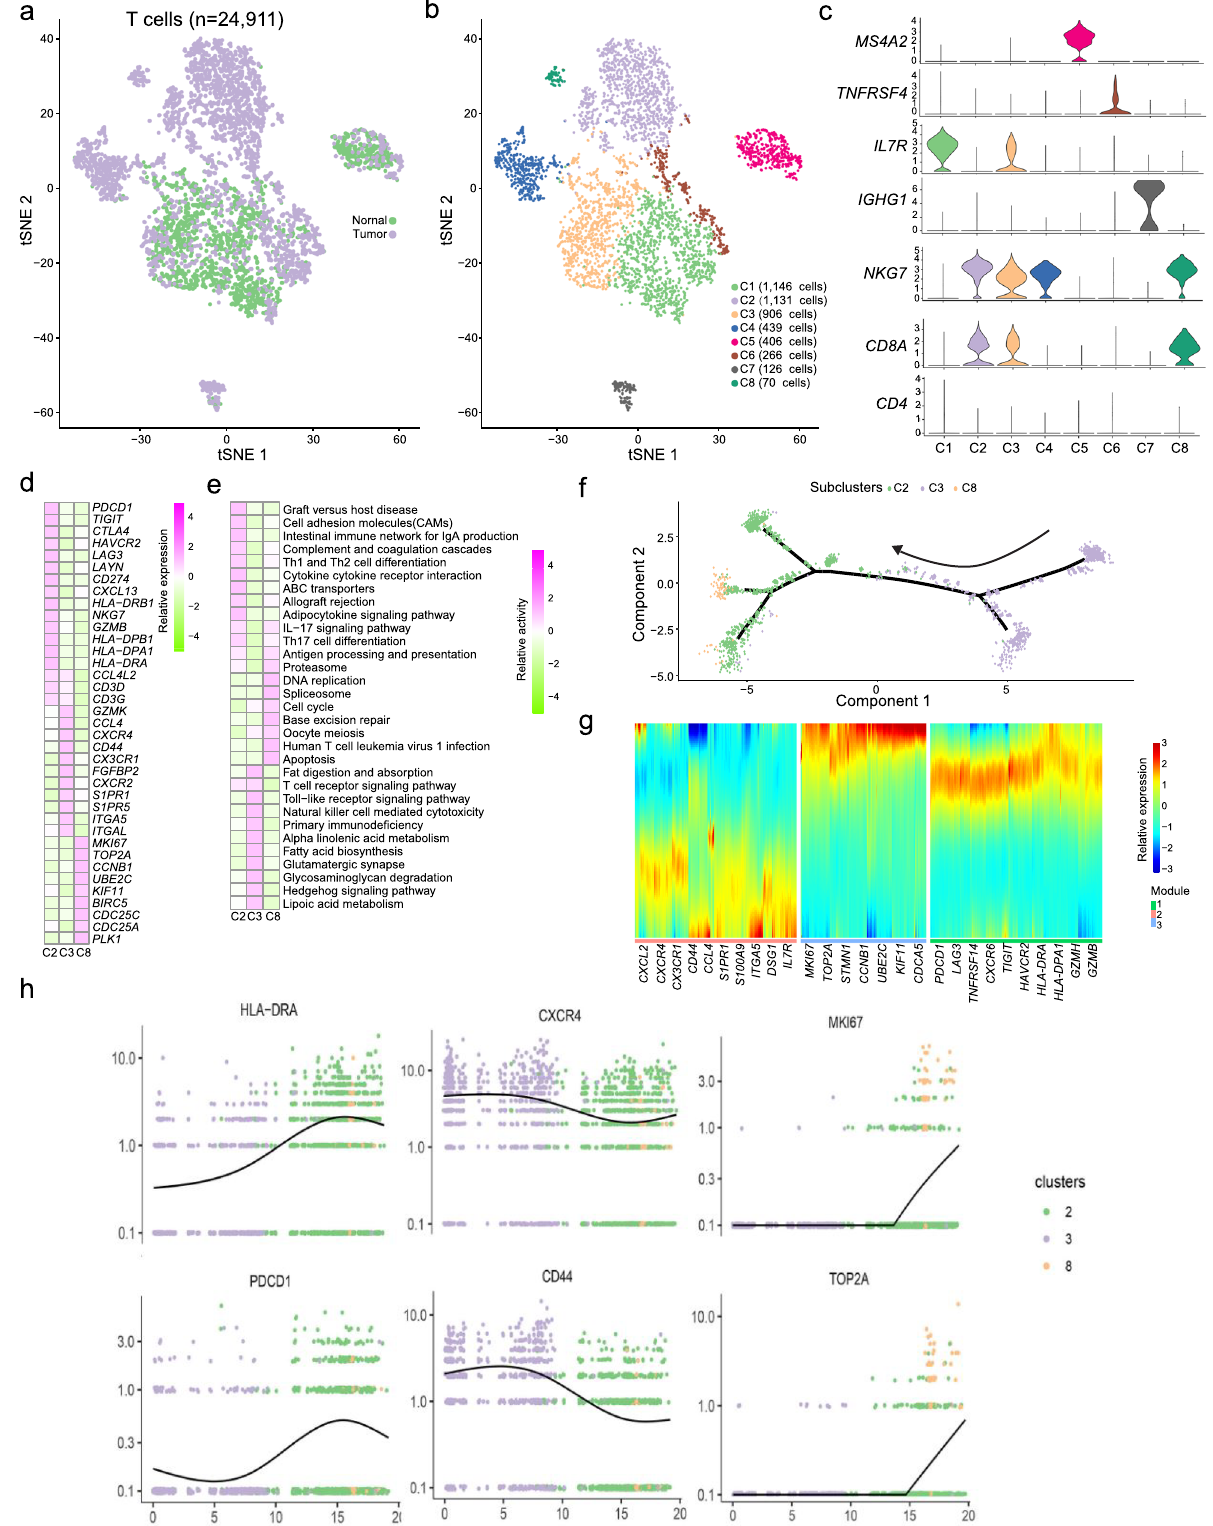
Fig. 4 The heterogeneity of CD8 + T cells in cervical cancer samples. a tSNE plot showing CD8 + T cells in tumor and NAT cervical samples. b tSNE plot showing subclusters of CD8 + T cells. c The relative expression levels of the CD4 , CD8A , NKG7 , IGHG1 , IL7R , TNFRSF4 , and MS4A2 gene across 8 subclusters of CD8 + T cells. d Heatmap showing the relative expression of top marker genes in the C2, C3, and C8 subcluster. e Heatmap showing the relative activities of signi fi cant biological processes in the C2, C3, and C8 subcluster. f Pseudo-time trajectory of the C2, C3, and C8 subcluster. g The expression patterns of genes in the identi fi ed modules. h The expression levels of the gene HLA-DRA , CXCR4 , MKI67 , PDCD1 , CD44 , and TOP2A along the pseudo-time trajectory across C2, C3 and C8